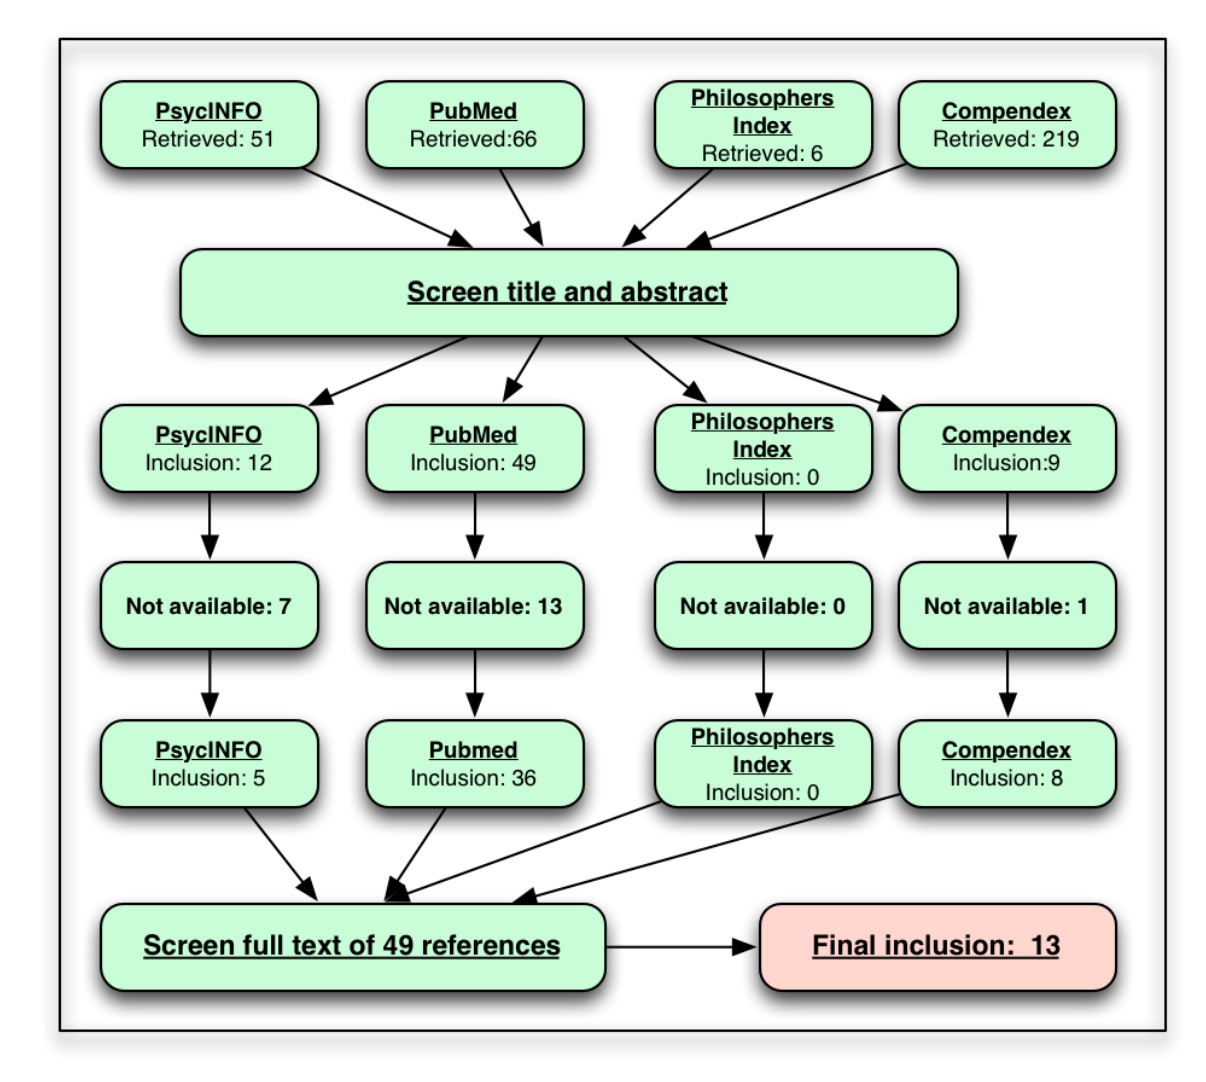
Figure 2. Inclusion/exclusion